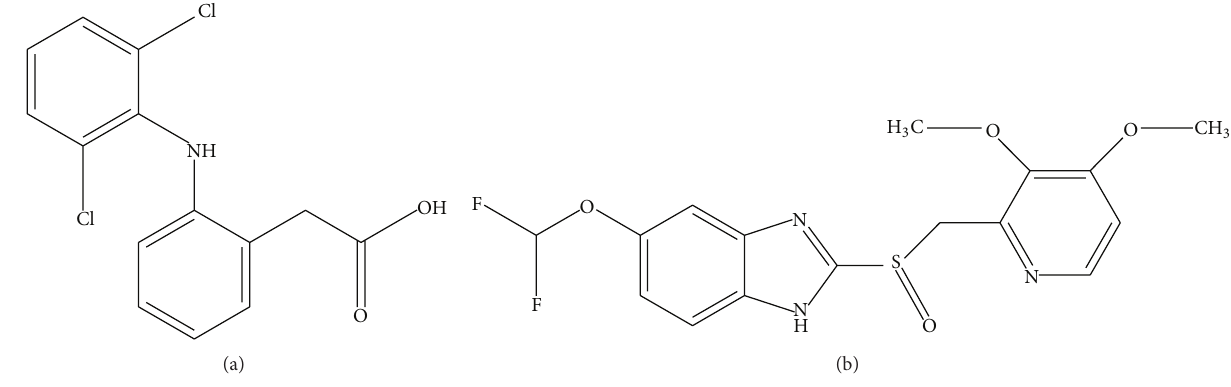
Figure 1: Chemical structures of (a) diclofenac and (b)